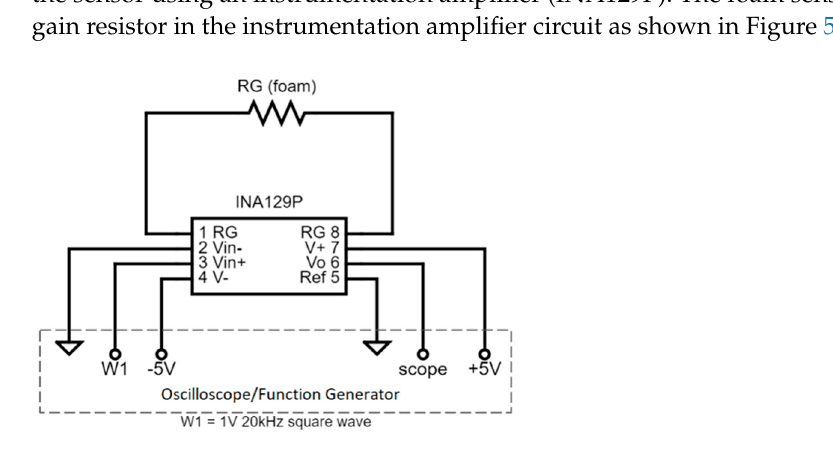
Figure 5. Schematic of sensor connection to oscilloscope/function generator for resistance measure- ments.